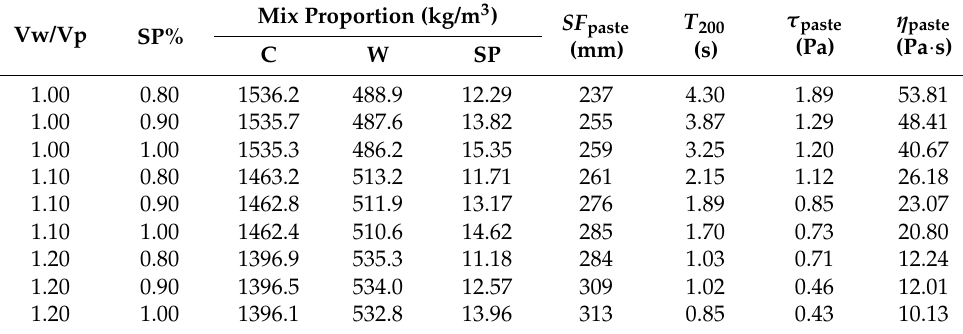
Table 4. Mix proportions and test results of paste in series 1.